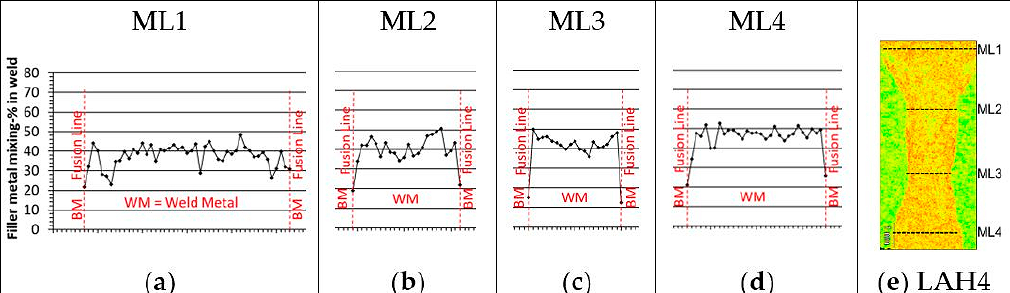
Figure 12. Filler metal mixing results from EDS stepwise characterization. ( a – d ) Filler metal mixing-% profiles of measurement lines 1–4 (ML1–ML4) from test weld LAH4 ( e ). In figures ( a – d ) one step between adjacent measurement points in the horizontal axis equals 100 micrometres.